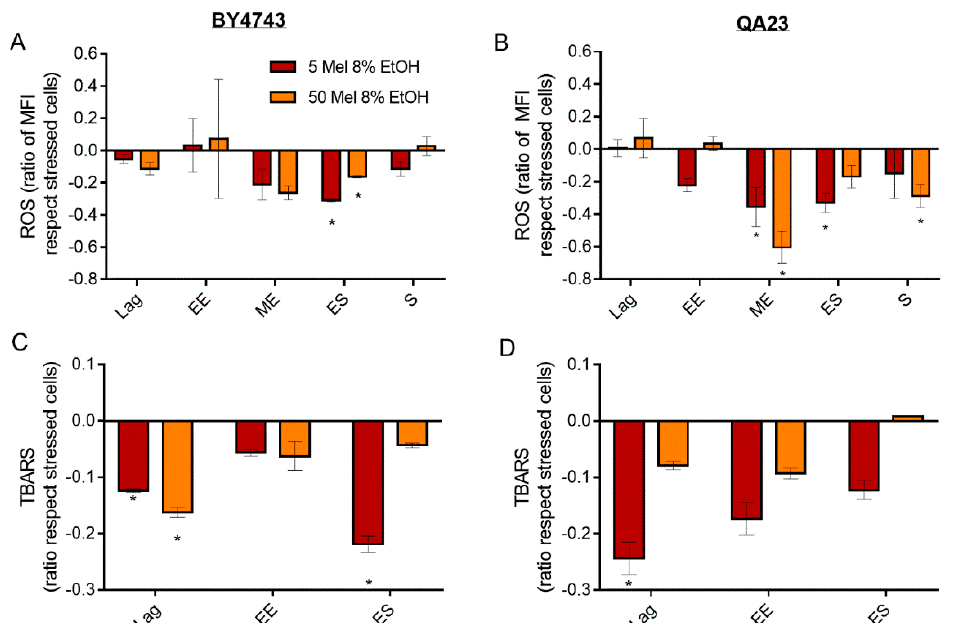
Figure 6. Effect of melatonin (Mel) supplementation (5 (red) or 50 (orange) µ M) of BY4743 ( A , C ) and QA23 ( B , D ) cells exposed to 8% ethanol in lag, early exponential (EE), mid-exponential (ME), early stationary (ES), and stationary (S) phases, on ( A , B ) ROS accumulation (ratio of MFI of stressed cells with Mel vs. stressed cells without Mel) and ( C , D ) lipid peroxidation (ratio of TBARS of stressed cells with Mel vs. stressed cells without Mel). Error bars represent the standard deviation, * indicates significant differences with respect to stressed cells without melatonin ( p -value < 0.05), and in Supplementary Table S6, there is a more complete statistical analysis. ROS stands for reactive oxygen species, and TBARS stands for thiobarbituric-acid-reactive substances.